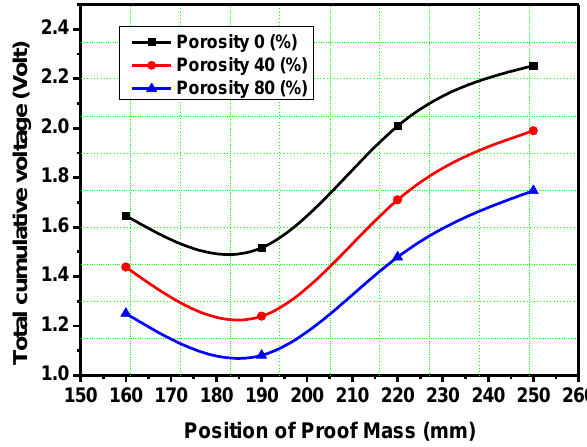
Figure 9. Effect of position of proof mass and porosities.